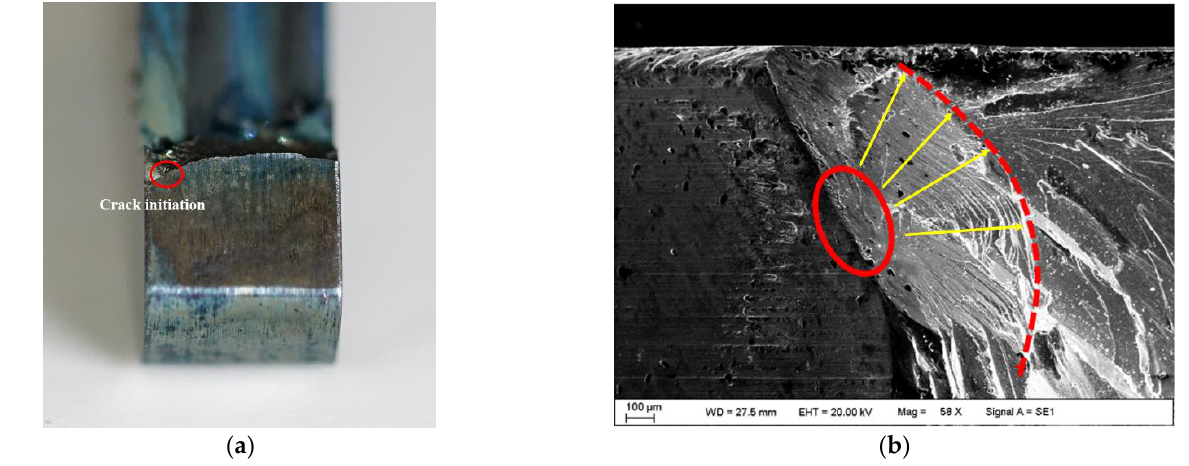
Figure 10. Observation of the cracked specimen. ( a ) Fractured dovetail specimen; ( b ) SEM of the fracture surface.